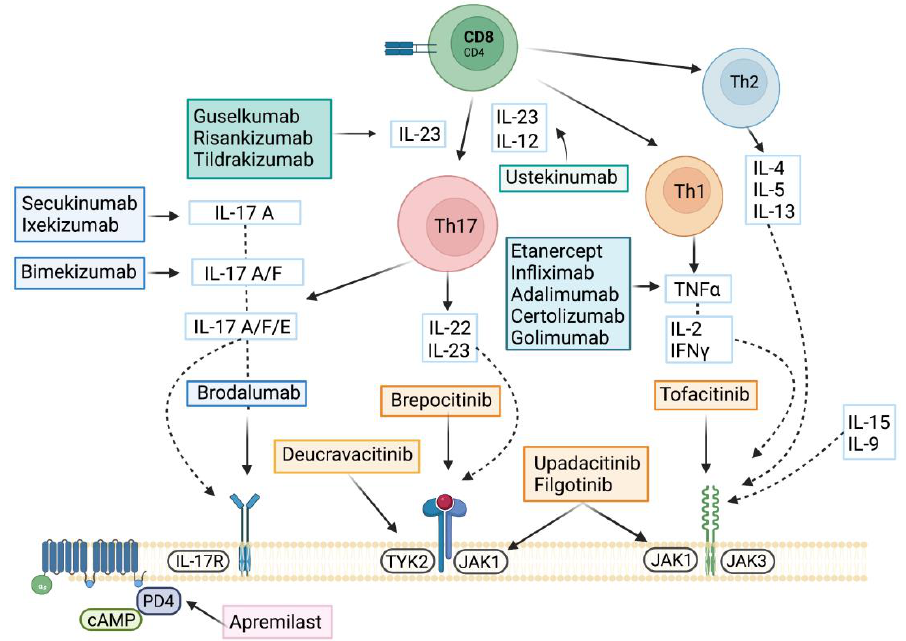
Figure 2. Targeted therapies. Mechanism of action of the latest approved or in-development molecules for the treatment of PsA. Interleukin 17 (IL-17) and isoforms IL-17A/F/E and IL17 receptor (IL-17R); janus kinase 1, 2, 3 (JAK1, JAK2, JAK3) and tyrosine kinase 2